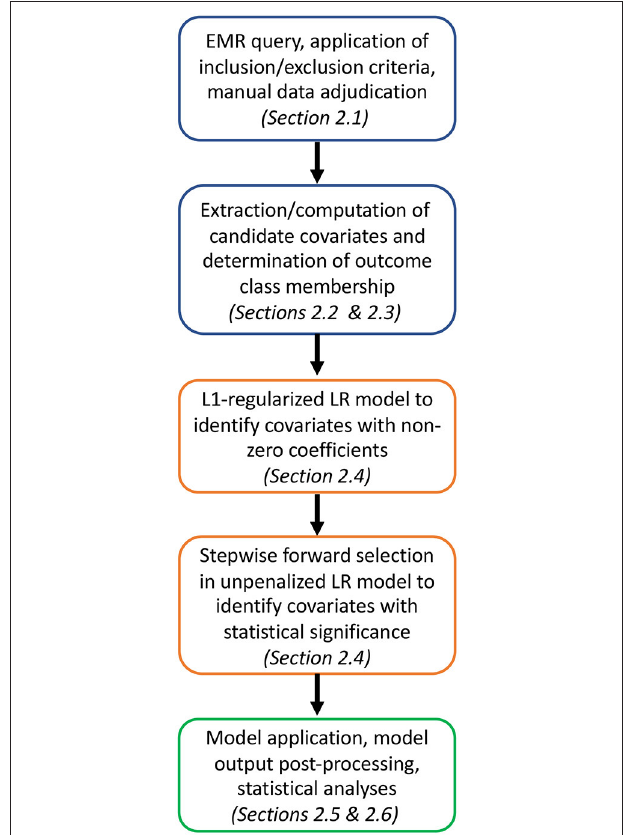
FIGURE 1 | Analysis pipeline from cohort selection and candidate covariate and outcome class assignment (blue) to model training and covariate down-selection (orange) to model application, validation and statistical analyses